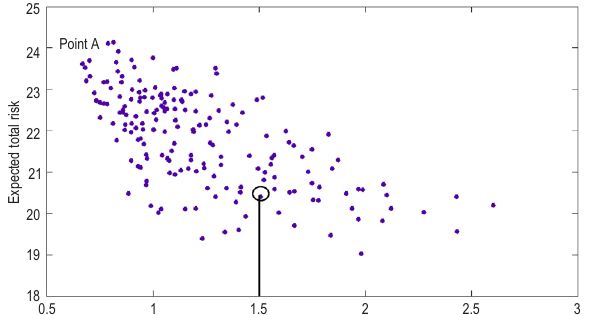
Fig. 5. An example of the application of model